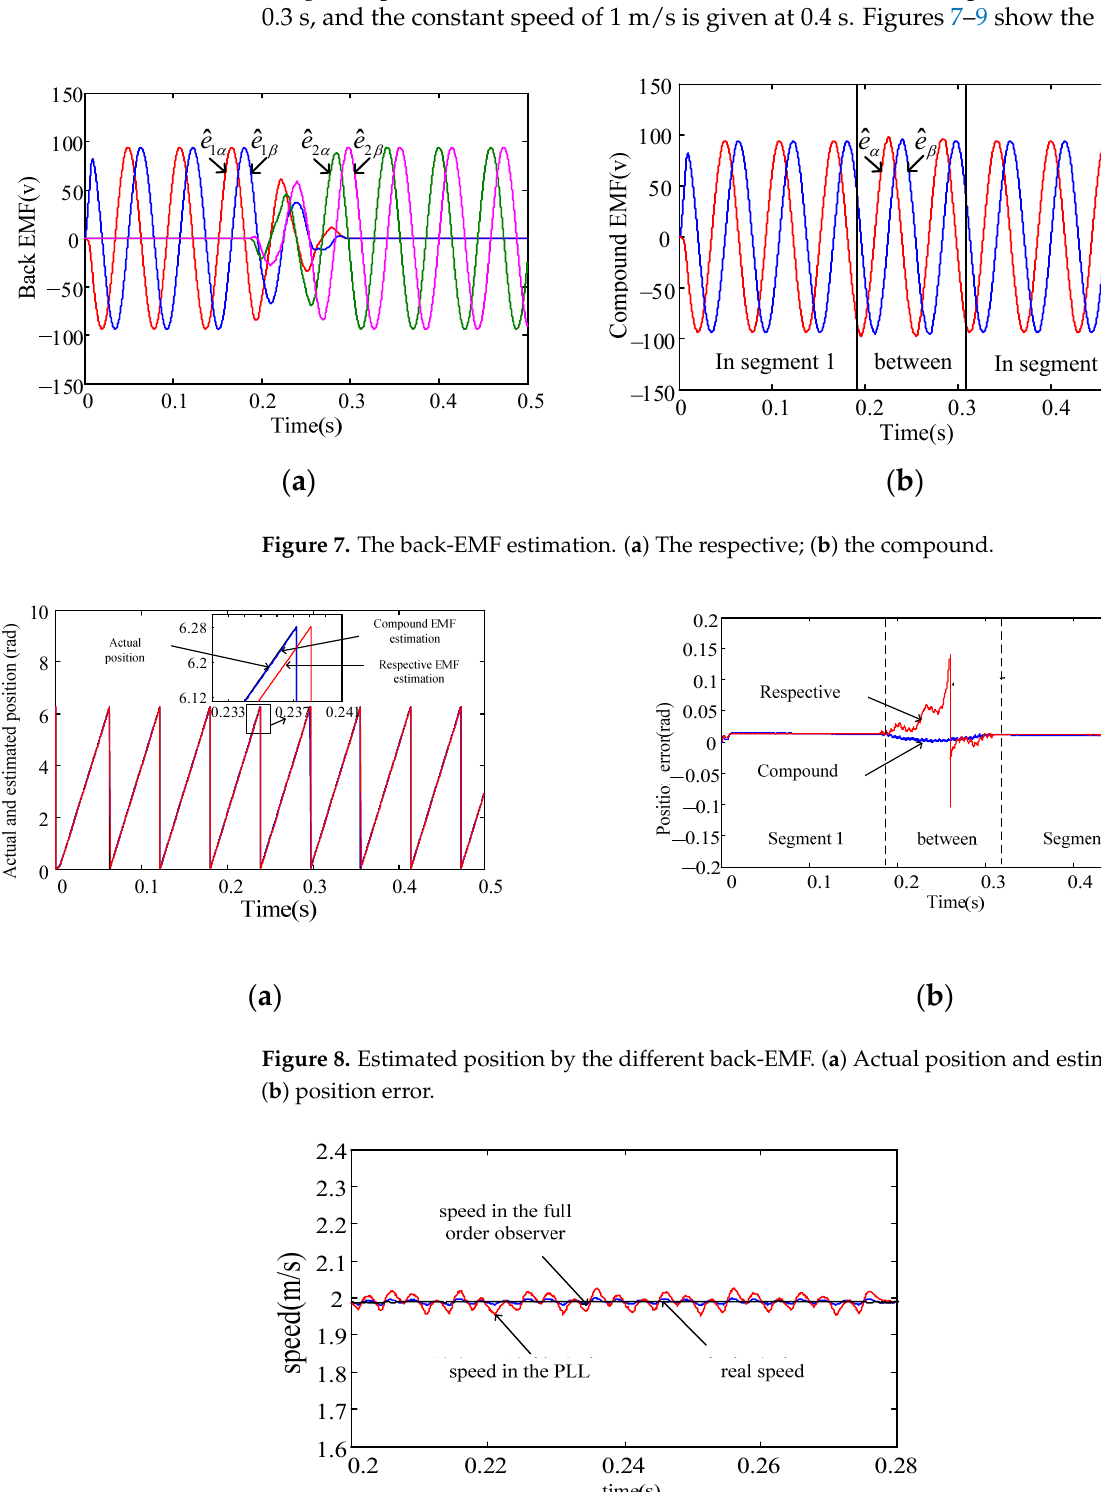
Figure 6. The diagram of the WS-PMLM sensorless drive.